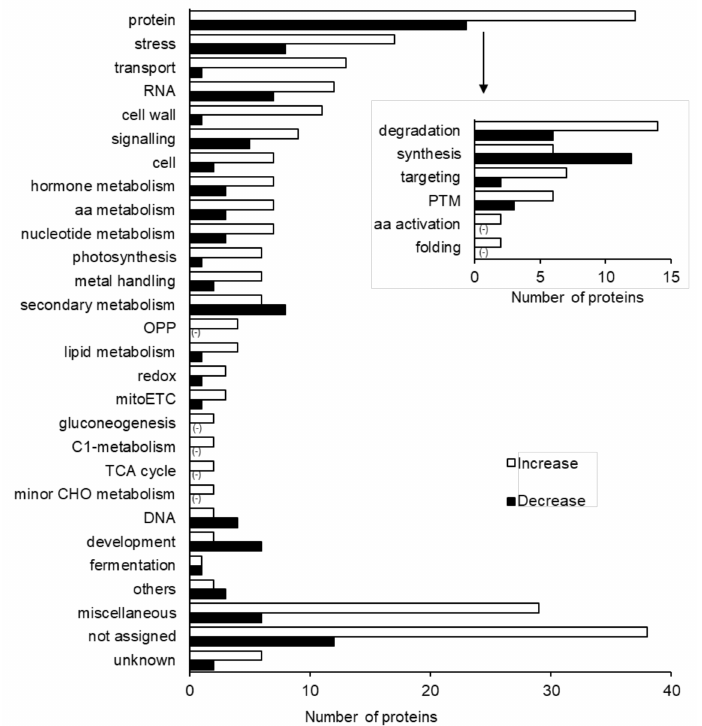
Figure 2. Functional categorization of proteins identified in flooding-stressed soybean treated with 5 ppm silver NPs / 8 µ M nicotinic acid / 0.1 mM KNO 3 . Proteins extracted from root were analyzed using a gel-free / label-free proteomic technique and significantly changed proteins were identified ( p < 0.05). The identified proteins were functionally categorized using MapMan bin codes. The x-axis indicates the number of identified proteins. Abbreviations: aa, amino acid; protein, protein synthesis / degradation / post-translational modification / targeting / folding; cell, cell division / organization / vesicle transport; PTM, post-translational modification; RNA, RNA processing / transcription / binding; OPP, oxidative pentose pathway; mito ETC, mitochondrial electron transport chain; C1 metabolism, carbon 1 metabolism; TCA, tricarboxylic acid cycle; CHO, carbohydrate. The negative sign shows zero proteins identified in the respective functional